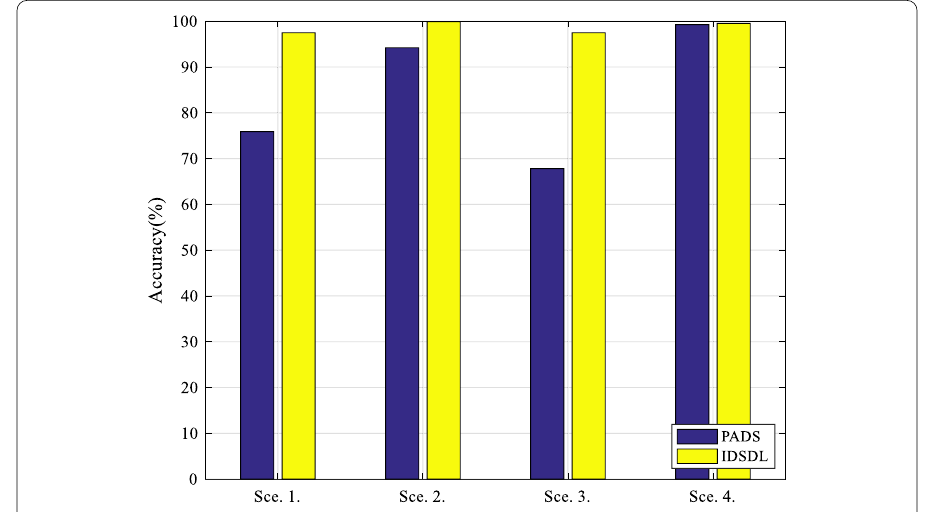
Fig. 11 Detection accuracies in four scenarios with PADS and IDSDL